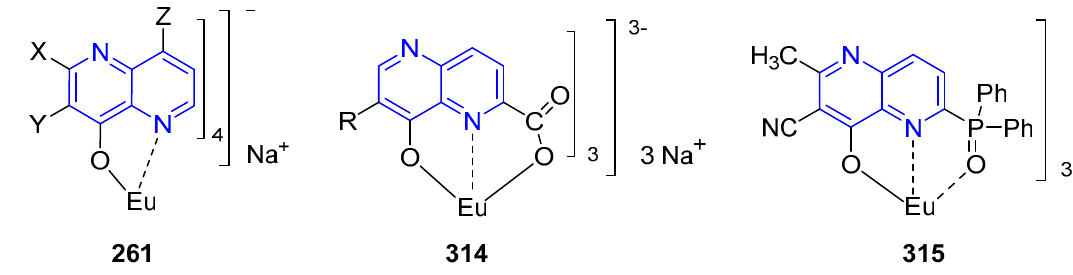
Figure 37. Dysprosium complexes as light emitters.